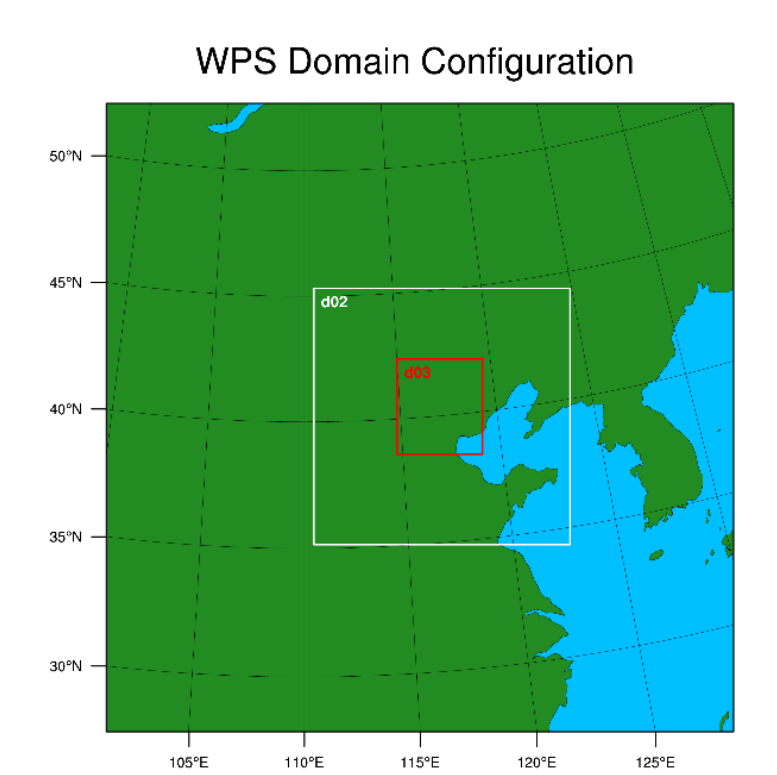
Figure 1. Domain configuration and location of the study area.